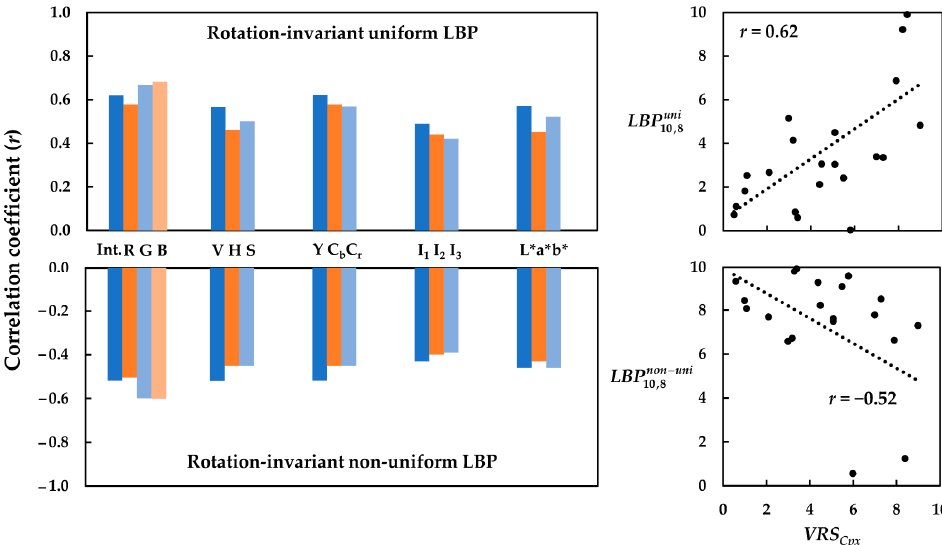
Figure 16. The correlation between the VRS Cpx of the textiles and uniform and non-uniform LBP features computed for the textile images with R = 10 pixels and N = 8 neighboring pixels in the sRGB, HSV, YC b C r , I 1 I 2 I 3 and CIELAB color spaces. Here, ‘Int.’ refers to sRGB intensity image ( left ); Scatter plots of uniform and non-uniform LBP features versus the corresponding VRS Cpx for the sRGB intensity images ( right ).